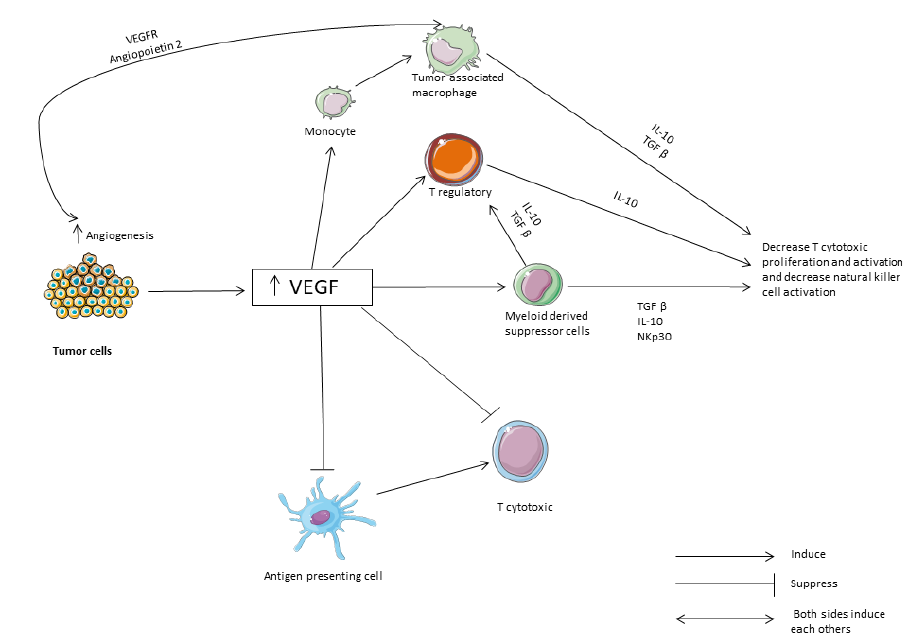
Figure 2. The role of VEGF and cytokines in immune suppression. VEGF: vascular endothelial growth factor. TGF: transformation growth factor.